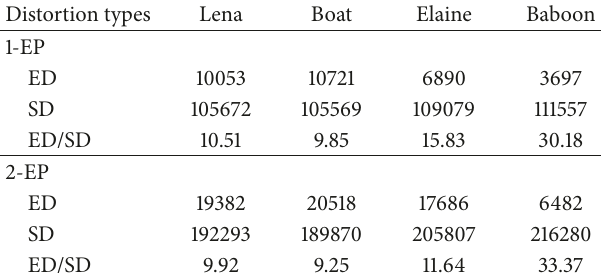
Table 1: Comparison of Tsai’s ED and